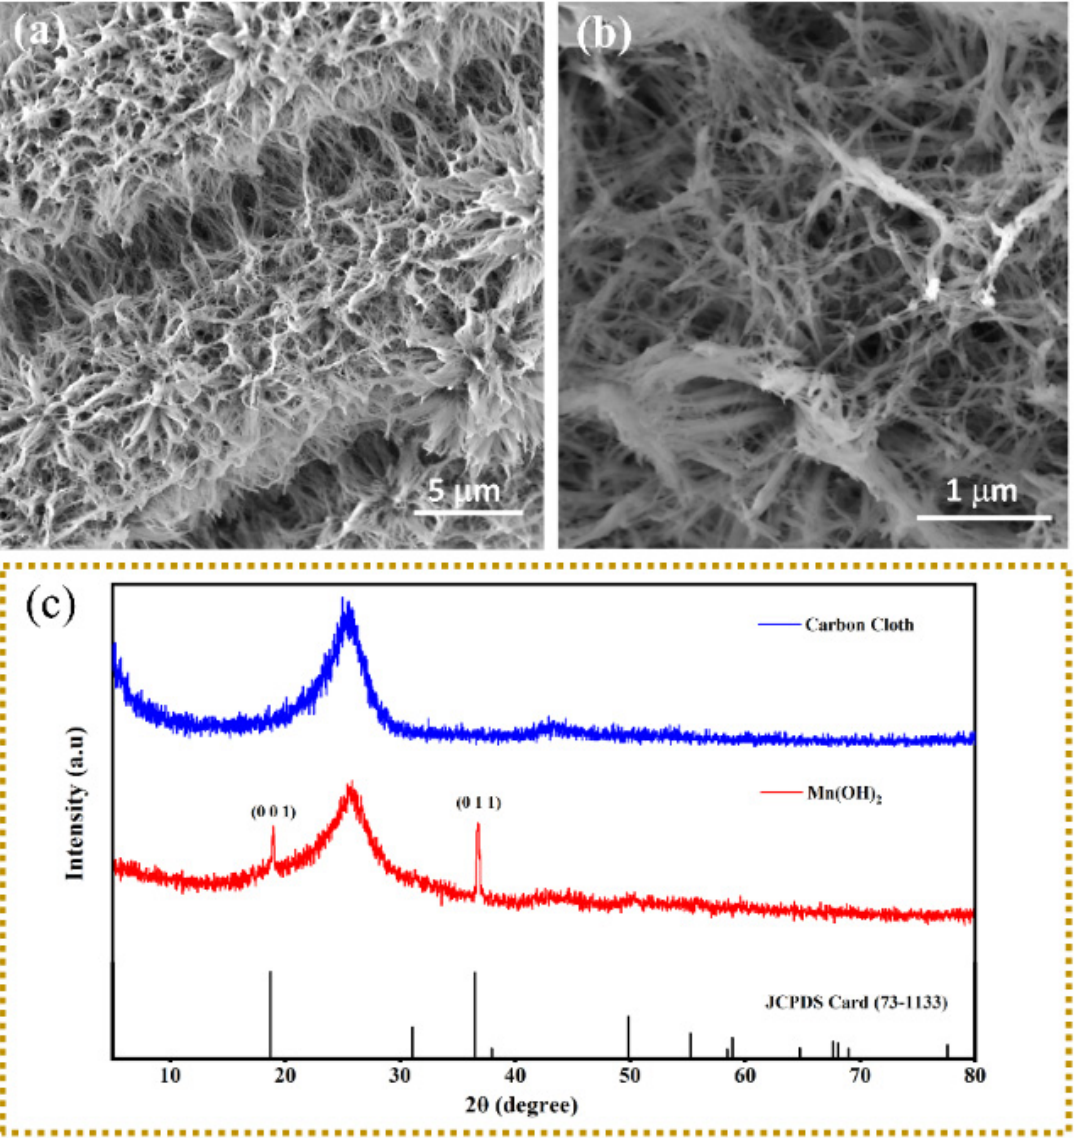
Figure 1. ( a , b ) SEM images; ( c ) XRD pattern of as-prepared Mn(OH) 2 nanowire arrays.